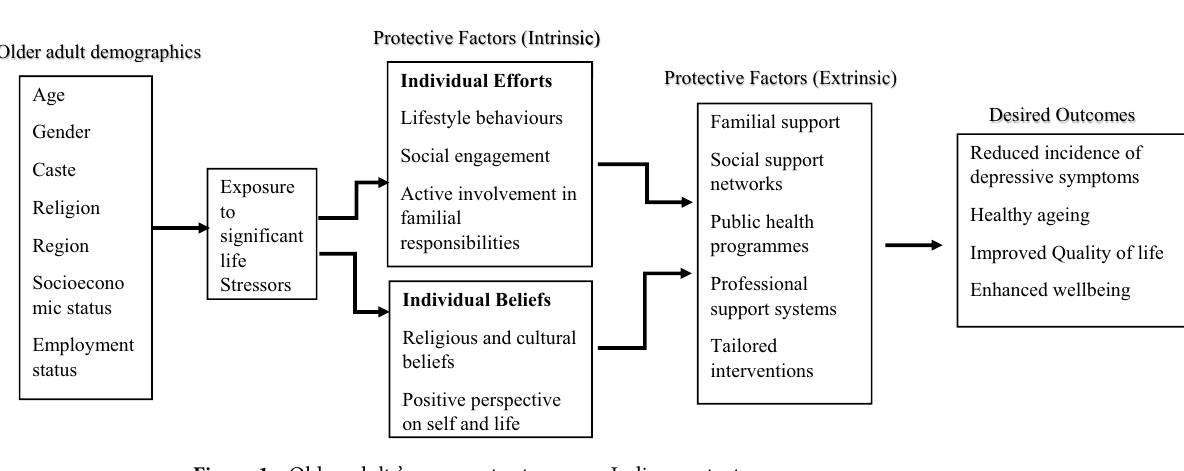
Figure 1. Older adults’ response to stressors—Indian